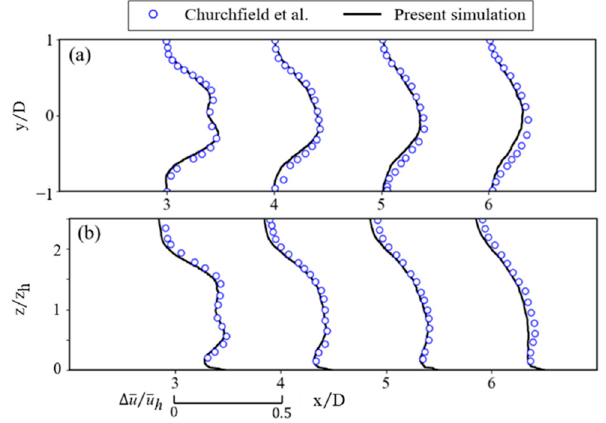
Figure 4. Profiles of the normalized mean streamwise velocity deficit in ( a ) the horizontal hub-height plane and ( b ) the vertical plane normal to the wind turbine under non-yawed conditions.